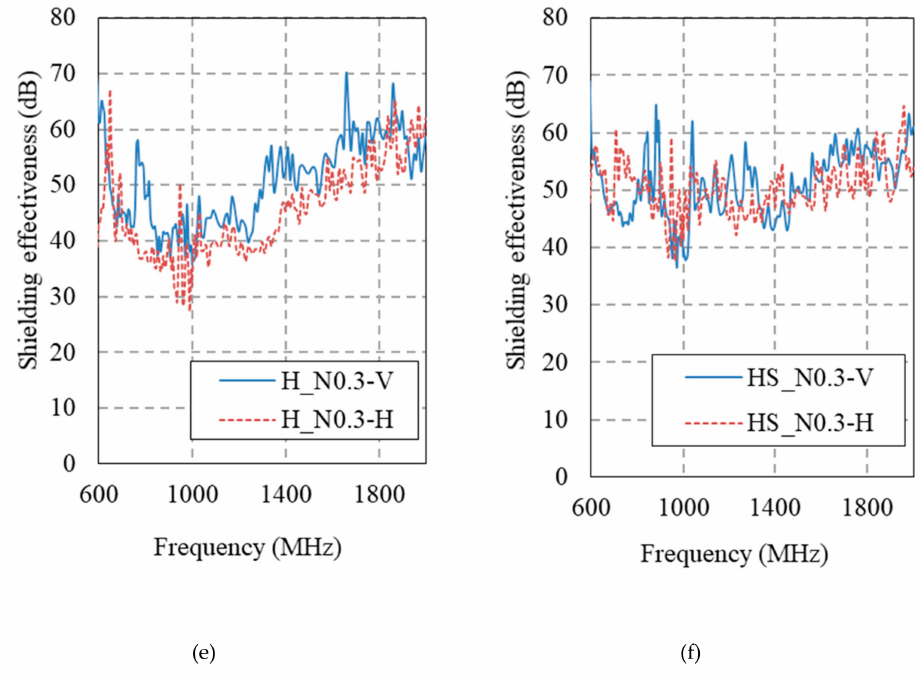
Figure 14. Electromagnetic shielding e ff ectiveness of 100 MPa-HPFRCC. ( a ) Plain; ( b ) 1.0% steel fiber;